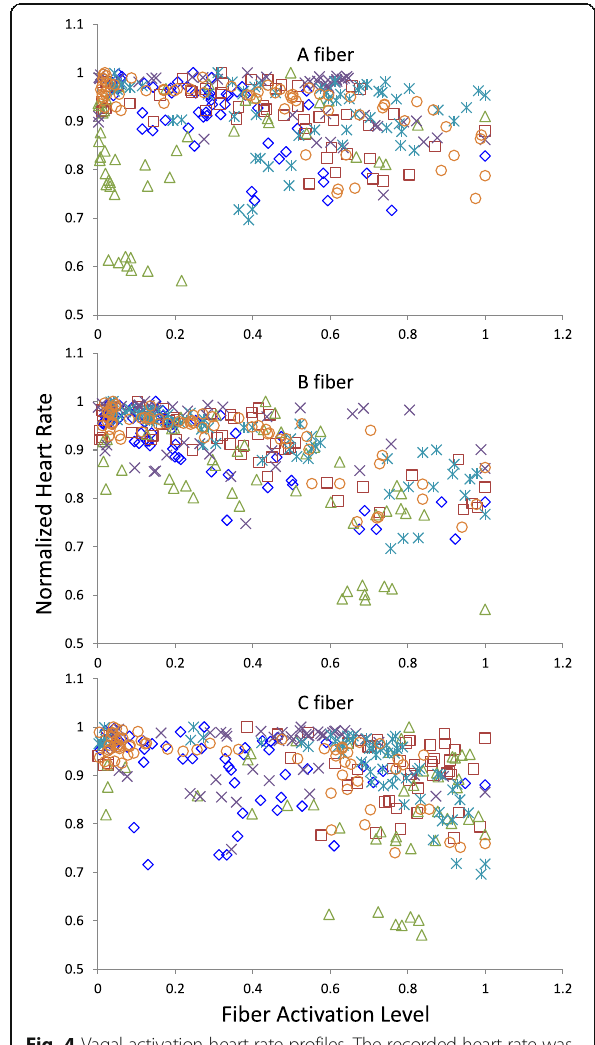
Fig. 4 Vagal activation-heart rate profiles. The recorded heart rate was plotted against the resulting nerve fiber activation levels from the same stimulation trial. The same data set as in Fig. 3 was used. Data for all animals are presented ( n =6, animals represented by different markers). Both the heart rate and fiber activation data were